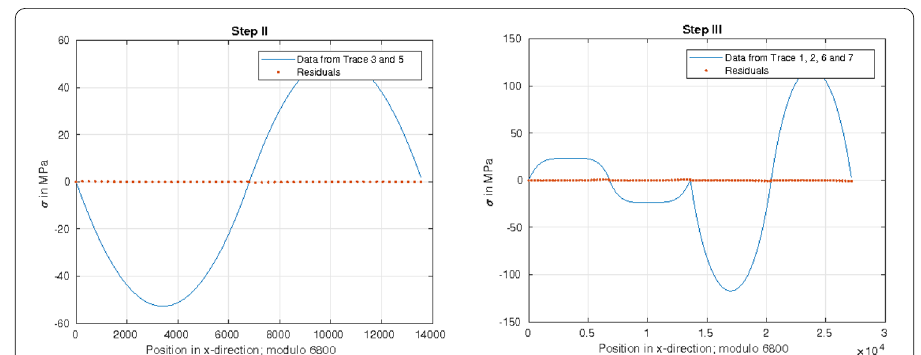
Figure 10 Left: Estimation of M y . Right: Estimation of M z + M w